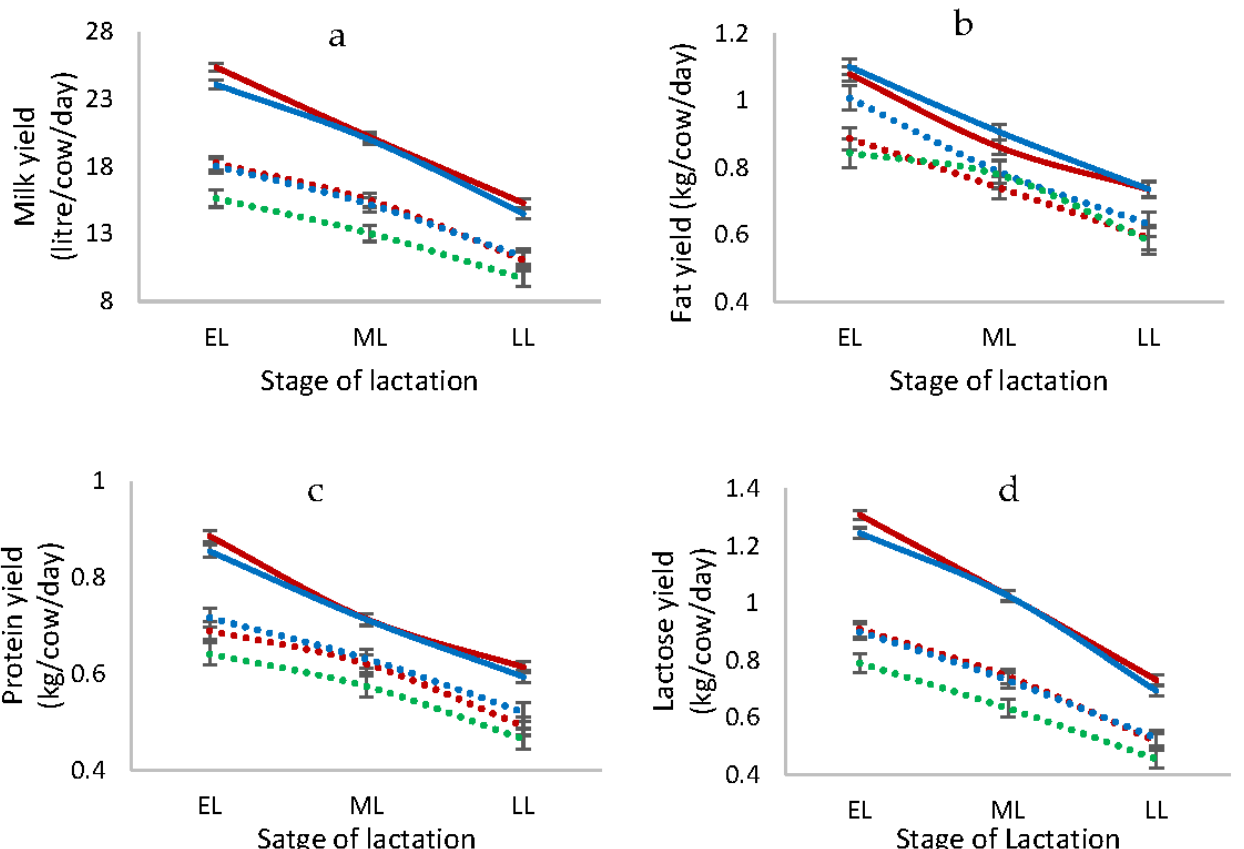
Figure 1. Daily yield of ( a ) milk, ( b ) fat, ( c ) protein, and ( d ) lactose in milk from Holstein-Friesian ( …. ), Holstein-Friesian ×Jersey ( …. ) and Jersey ( …. ) cows milked OAD and Holstein-Friesian ( — ) and Holstein-Friesian ×Jersey ( — ) cows milked TAD during the production season 2020–2021. EL = early lactation (<90 days); ML = mid lactation (90–180 days); LL = late lactation (>180 days). The vertical bars show standard errors.